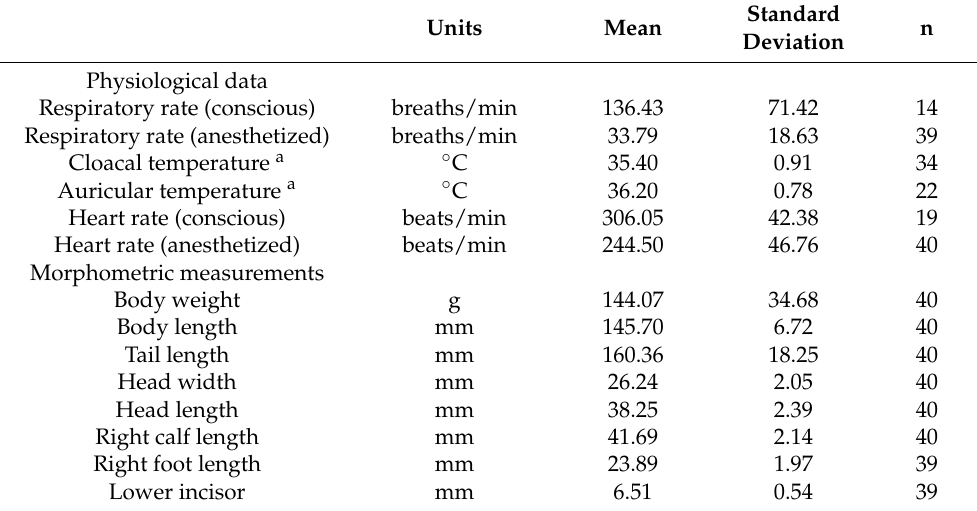
Table 1. Physiological data and morphometric measurements of sugar gliders, including mean and standard